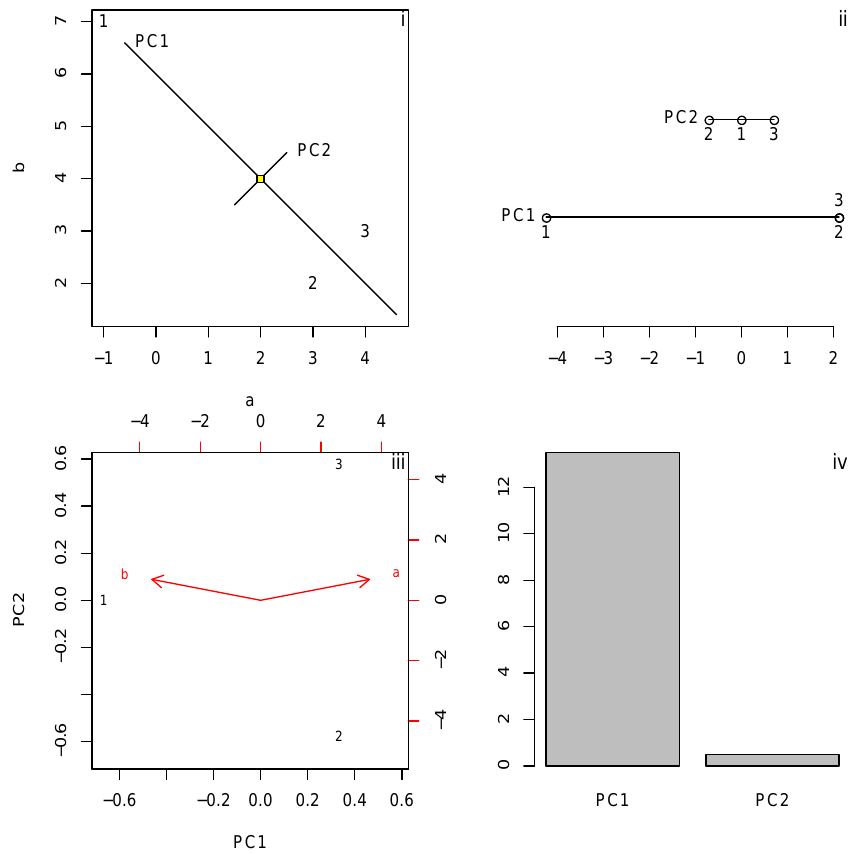
Figure 4. ( i )—Three samples (1, 2 and 3) of bivariate ( a and b ) data ( X in Equation (7)). The yellow square marks the arithmetic mean ( C in Equation (8)), the cross marks the two principal directions ( D in Equation (8)) stretched by the diagonal elements (i.e., the standard deviations) of V (Equation (8)); ( ii )—The projection of the data points on these two directions yields two principal components ( P in Equation (9)), representing a one-dimensional representation of the two-dimensional data; ( iii )—A biplot of both principal components along with the loadings of the two variables shown as arrows; ( iv )—The squared diagonal values of V (Equation (8)) indicate the relative amounts of variance encoded by the two principal